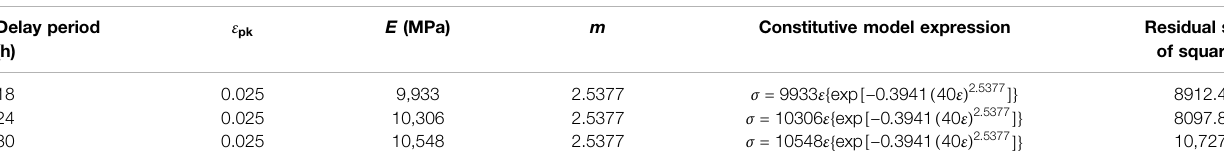
TABLE 6 | Parameters of constitutive model of RPC with m equal to 2.5377.